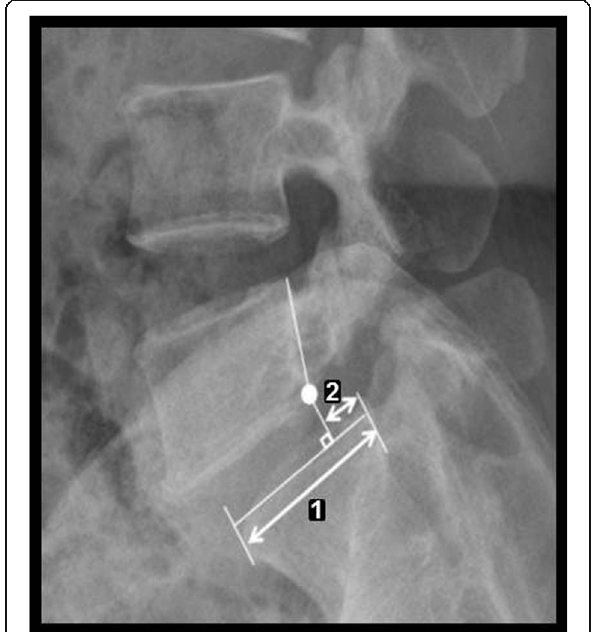
Fig. 1 Degree of spondylolisthesis (%) = distance (2)/distance (1) × 100%. The spondylolisthesis degree was measured as a percentage of the distance from the posterior border of the caudal vertebra to the posterior border of the rostral vertebra, normalized to the superior end plate diameter of the